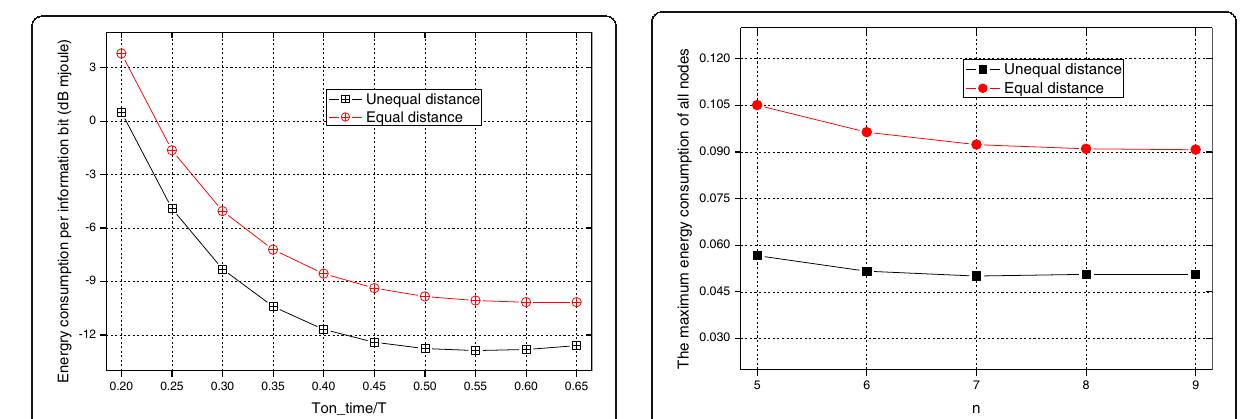
Fig. 20 The maximum energy consumption at optimal duty cycle under UDNP and EDNP (MPSK)